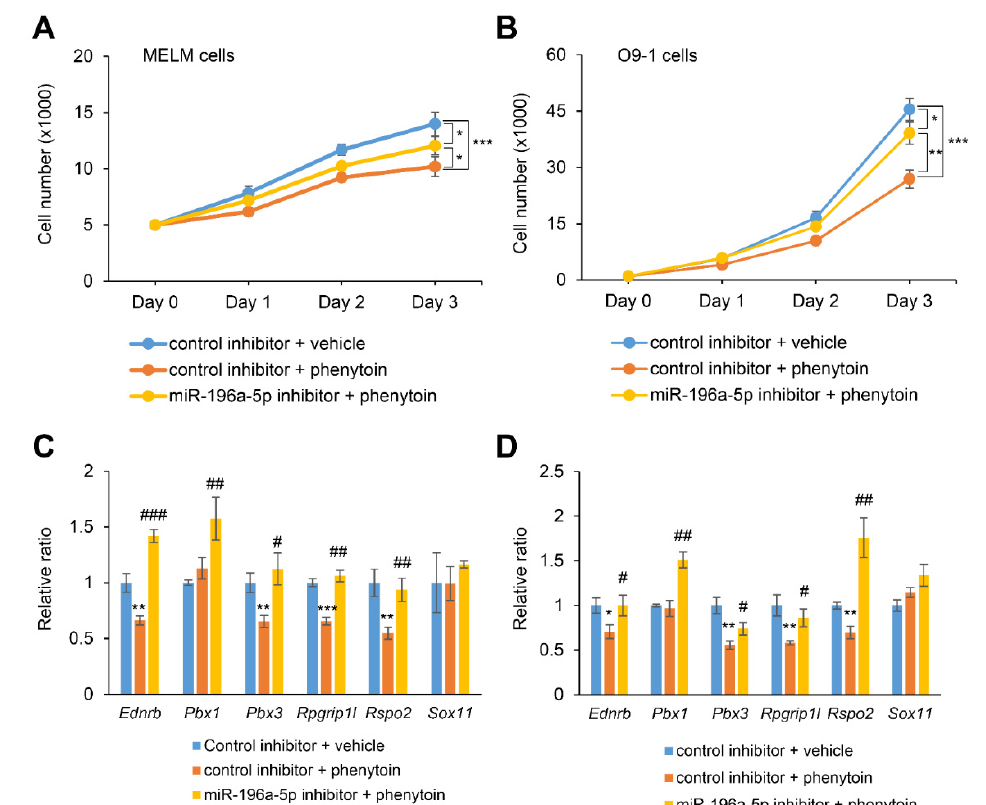
Figure 4. Normalization of miR-196a-5p expression restores phenytoin-induced cell proliferation defects in mouse embryonic lip mesenchymal (MELM) and O9-1 cells. ( A , B ) Cell proliferation assays with MELM cells ( A ) or O9-1 cells ( B ) treated with 50 μ g/mL phenytoin under miR-196a-5p inhibitor for 24, 48, or 72 h. * p < 0.05, ** p < 0.01, and *** p < 0.001. n = 6 per group. ( C , D ) Quantitative RT-PCR for the indicated genes after treatment of MELM cells ( C ) or O9-1 cells ( D ) with phenytoin under miR-196a-5p inhibitor for 72 h. * p < 0.05, ** p < 0.01, and *** p < 0.001 versus control inhibitor + vehicle. # p < 0.05, ## p < 0.01, and ### p < 0.001 versus control inhibitor + phenytoin. n = 6 per group.